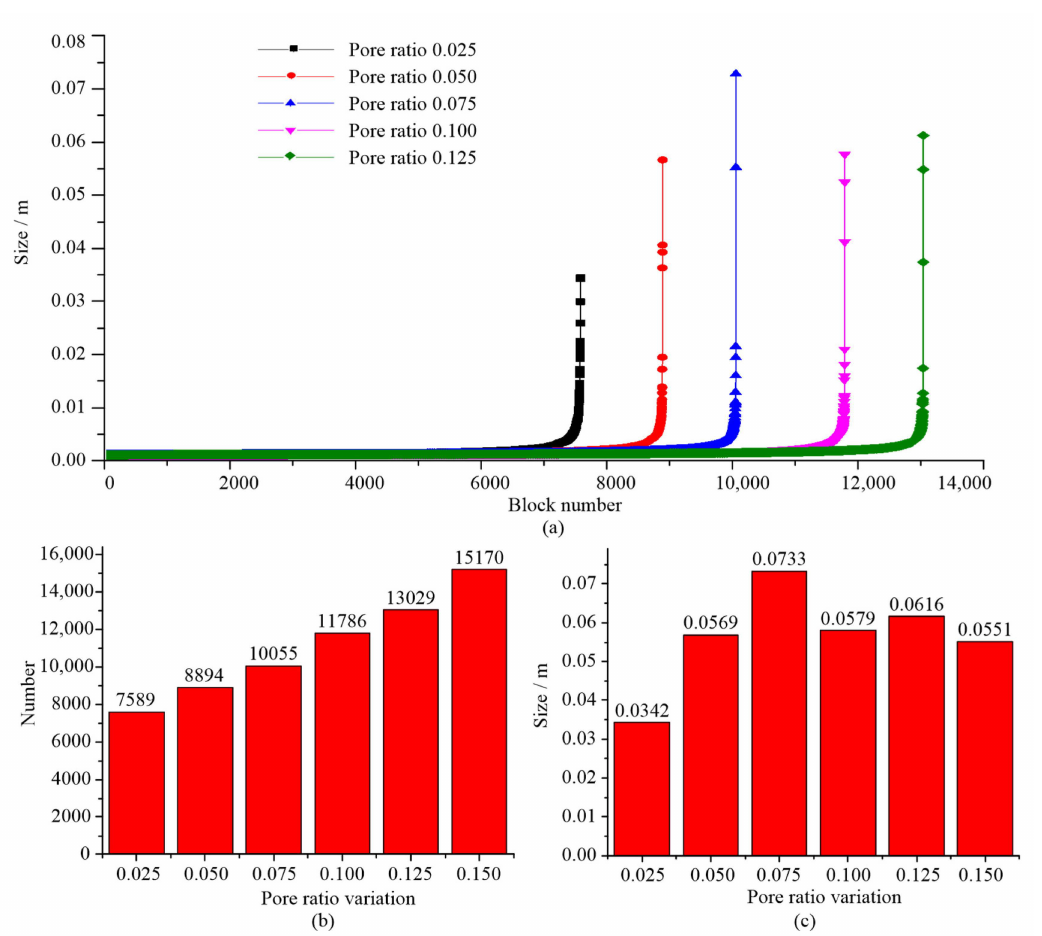
Figure 8. The maximum number and size statistics of the fracture block of coal samples with different pore ratios: ( a ) characteristic size curves of fracture rock block; ( b ) fracture block number comparison; and ( c ) maximum block size